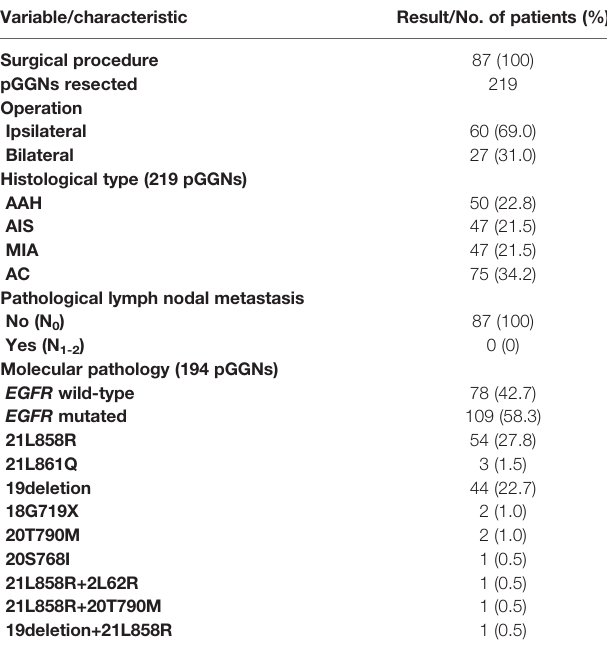
TABLE 1 | Clinical characteristics of 87 patients. Variable/characteristic